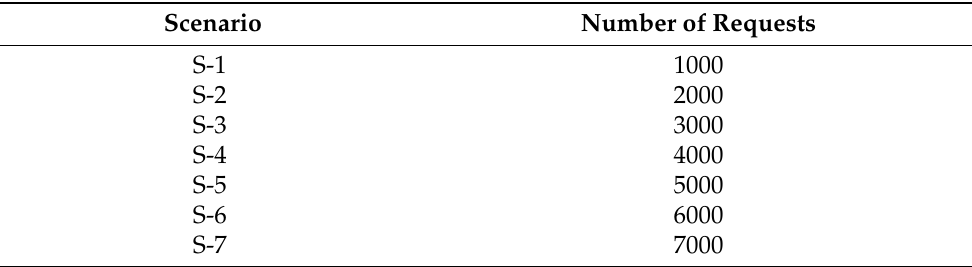
Table 6. EDoS attack simulation with different numbers of